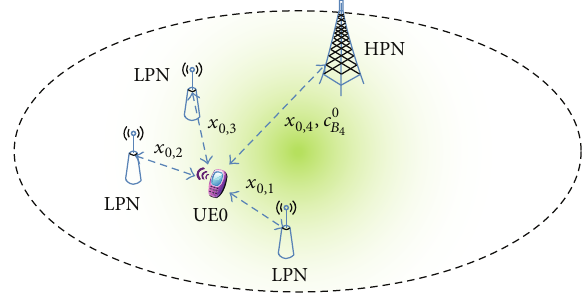
Figure 1: User association in the hyperdense